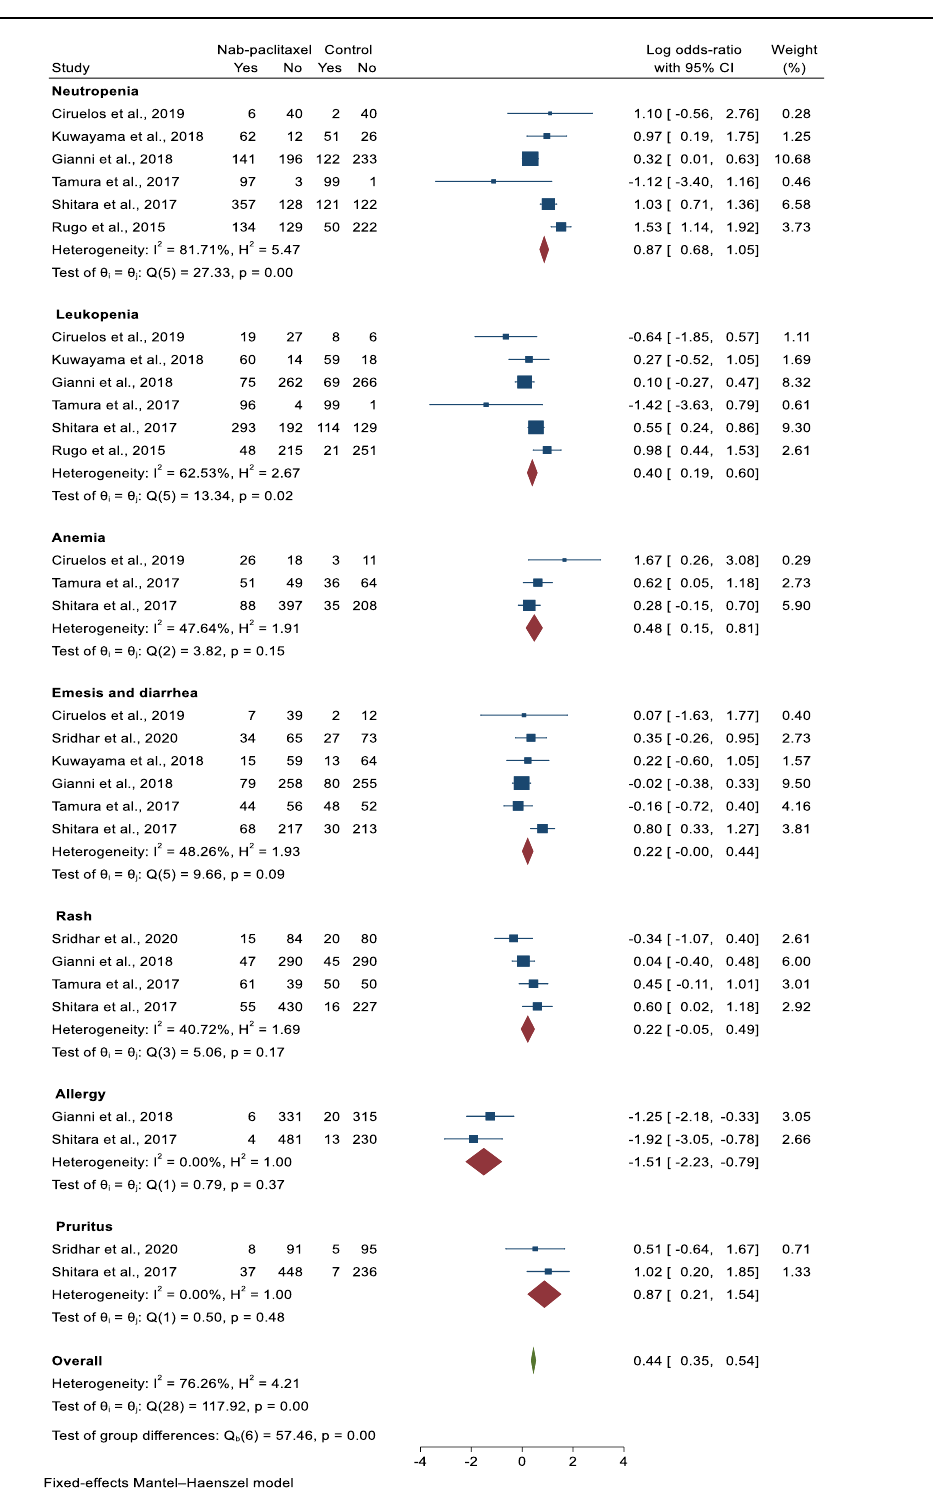
Fig. 7. The forest plots showed symptom and